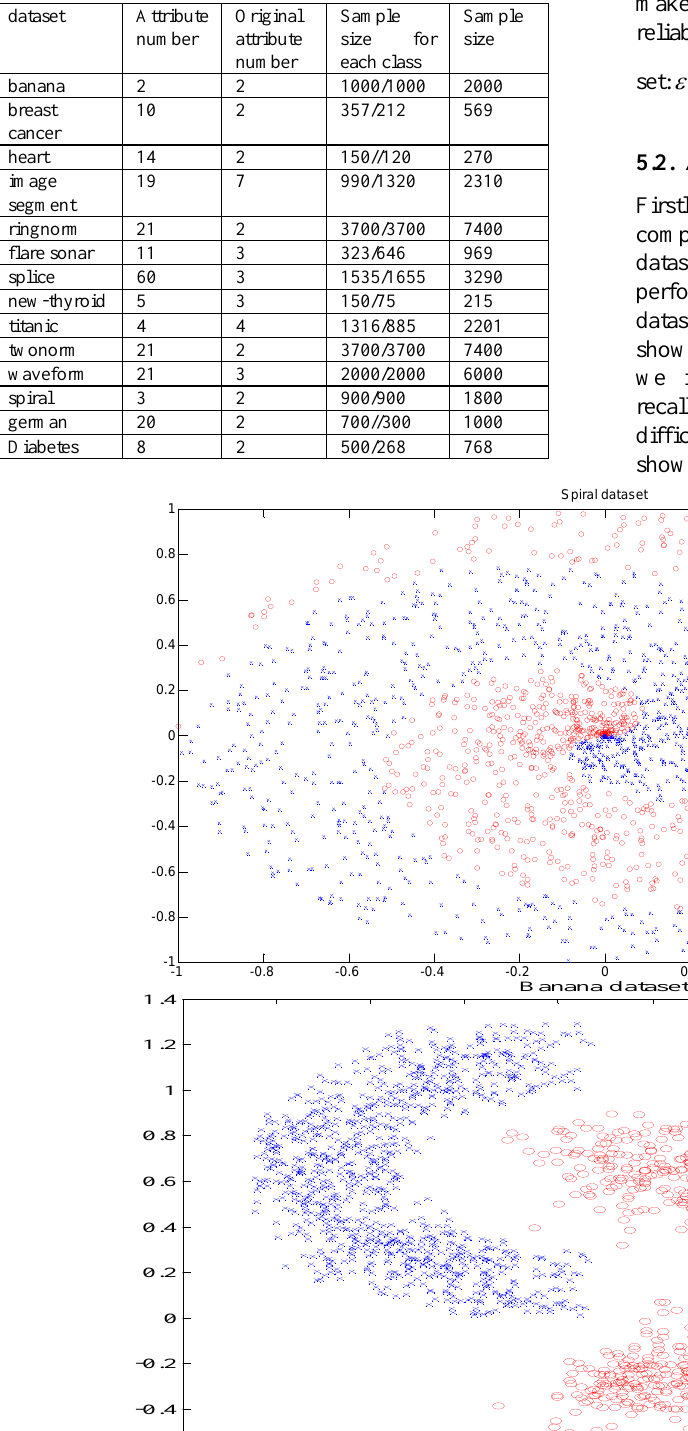
Table 2. Dataset description in the experiments